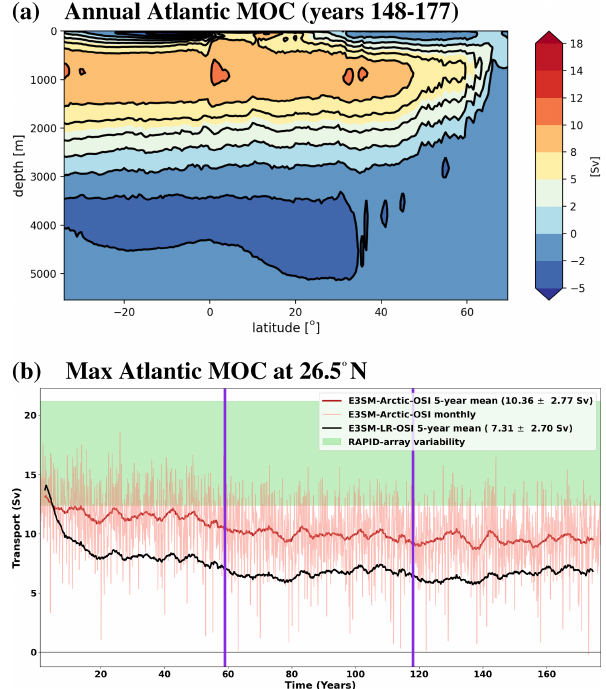
Figure 5. (a) Annual MOC streamfunction computed over the At- lantic Ocean and over years 148–177 of the E3SM-Arctic-OSI sim- ulation (black contours are every 2Sv); (b) time series of the 5- year running average maximum Atlantic MOC detected at 26.5 ◦ N (latitude of the RAPID-MOCHA observational array) from E3SM- Arctic-OSI (dark red line) and E3SM-LR-OSI (black line). The light red line shows E3SM-Arctic-OSI monthly values. The num- bers shown in the insets are the mean and standard deviations of the annual model values, computed over the full time series. The RAPID array typical variability (16 . 8 ± 4 . 4Sv) is shaded in green. Finally, the purple vertical lines show the transition across JRA cy-